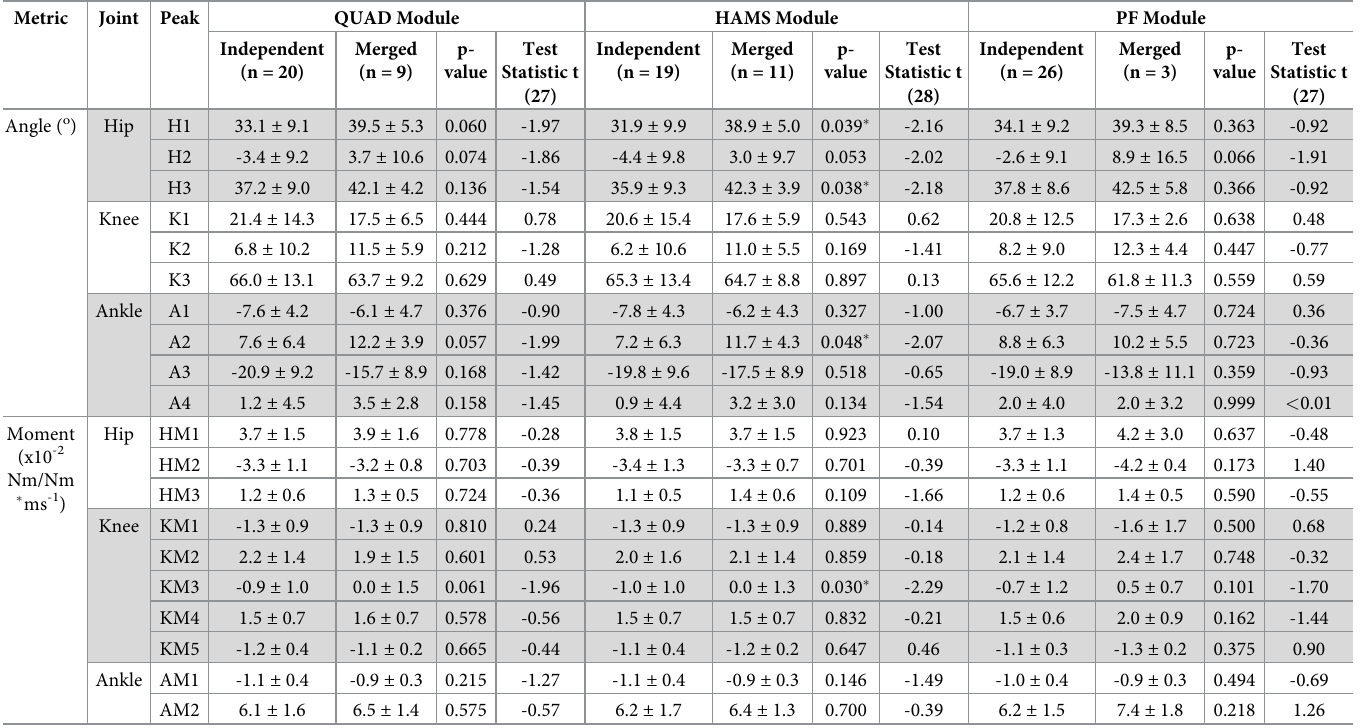
Table 6. Peak joint angles and moments by common module.